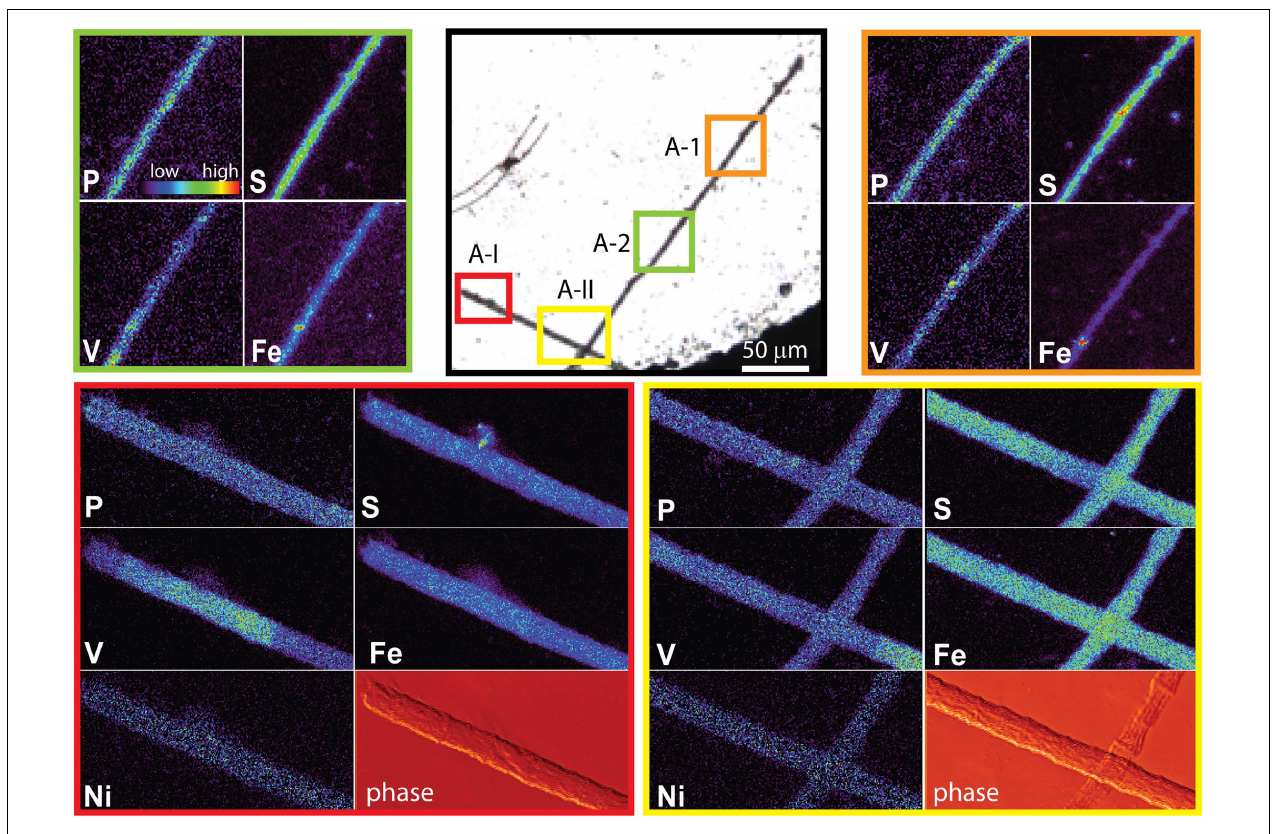
contrast image does not follow the color scale for the element maps. The location of each analyzed trichome section is indicated on the light micrograph. MAP A-1 (orange) and map A-2 (green) were recorded at the GSECARS beamline, while maps A-I (red) and A-II (yellow) were recorded at 2ID-E.